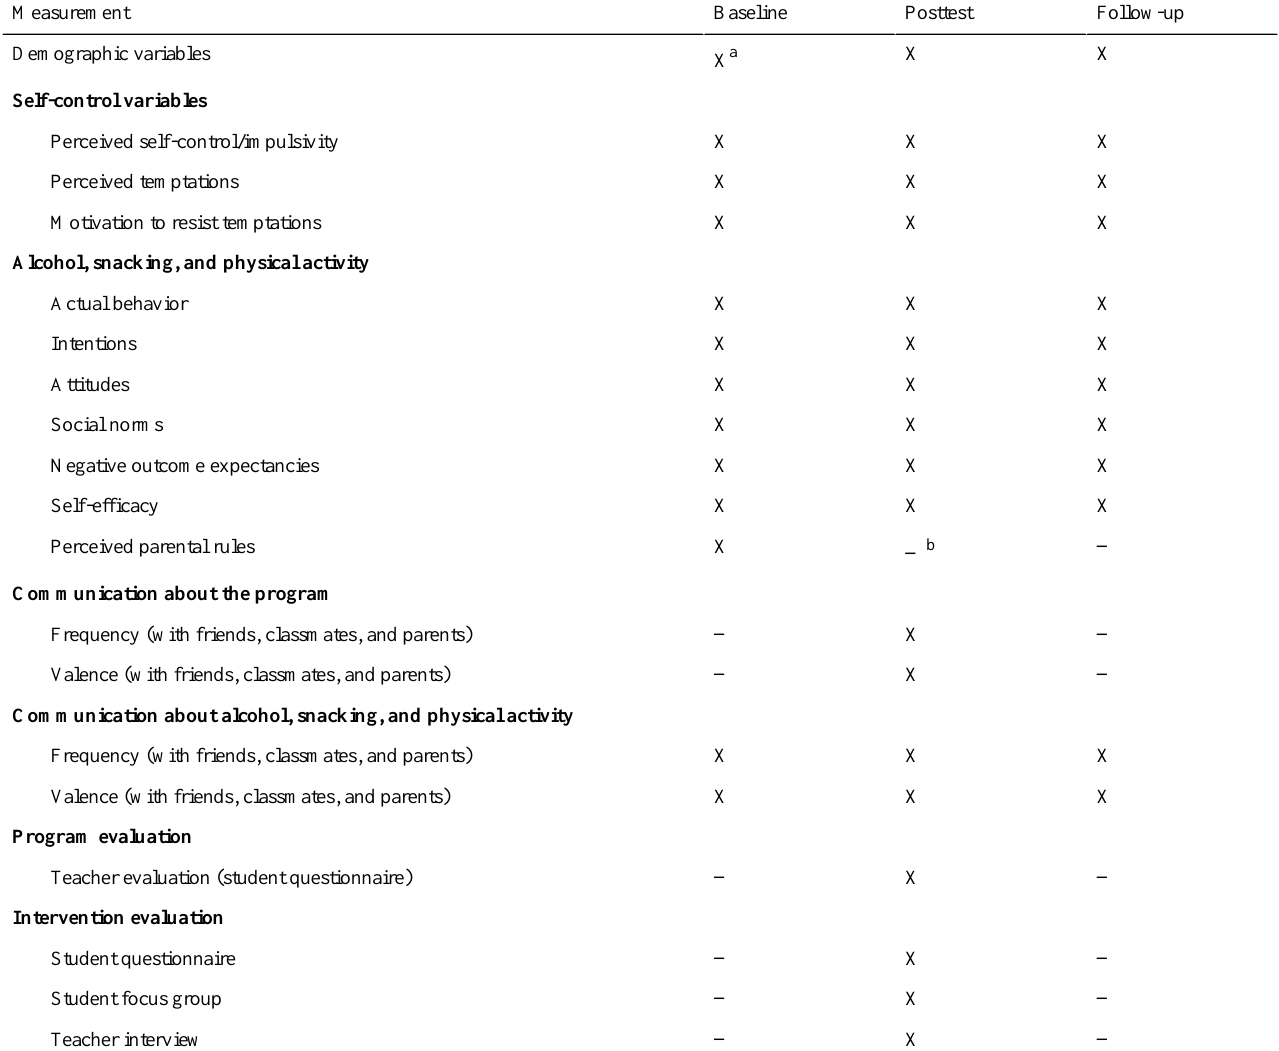
Table 1. Overview of measurements.